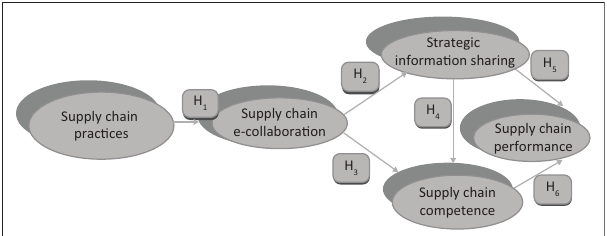
FIGURE 1: The research conceptual framework. H, hypothesis.